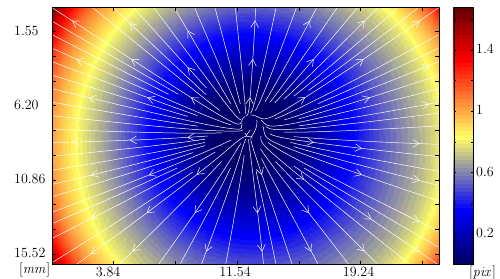
Figure 8: Color-shift estimation in pixels modelled for the red to green colorband of the fixed-wing system.